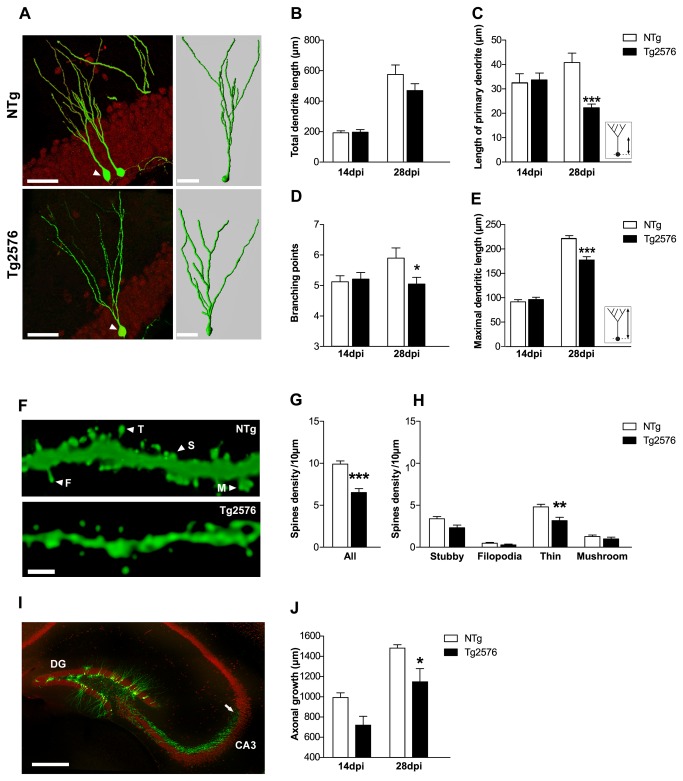
Impaired morphological development of new granule neurons in 3 month-old Tg2576 mice.(A) Confocal images (left) illustrating typical retrovirally GFP-labeled (GFP+, green) neurons 28 days post-injection (dpi) in the dentate gyrus of 3 month-old NTg and Tg2576 mice (neuronal marker NeuN, red) and their corresponding 3D reconstruction (right) illustrating the arborization and branching points of GFP+ neurons. (B) No difference was found in the total dendritic length of GFP+ neurons from NTg and Tg2576 mice (n=3-6 mice/group and 15-20 GFP+ cells/group). (C) The length of the primary dendrite was measured as indicated in inset. At 28dpi GFP+ neurons in Tg2576 mice exhibited a shorter primary dendrite compared to NTg mice (n=3-4 mice/group, n=20-25 GFP+ cells/group). (D) Number of branching points was counted in 14 and 28dpi GFP+ neurons (n=3-4 mice/group, 20-25 GFP+ cells/group). At 28dpi, GFP+ neurons exhibited less branching points in Tg2576 mice compared to NTg mice. (E) Maximal dendritic length of GFP+ neurons as quantified as illustrated in inset. At 28dpi, Tg2576 mice displayed shorter maximal dendritic length compared to NTg (n=3-4 mice/group and n=20-25 GFP+ cells/group). (F) Maximal projection of z-stacks confocal images illustrating dendritic segments from 28dpi GFP+ neurons, from which dendritic spines were counted and classified as stubby (S), filopodia (F), thin (T) or mushroom (M) according to morphological criteria described in the methods. (G) Spine density estimated from 28dpi GFP+ neurons (n=3 mice/group, 4-8 segments/mouse, 200-300µm of dendritic segments analyzed/mouse) was reduced in 3 month-old Tg2576 mice compared to NTg. (H) Among all classes, the density of thin spines was reduced in Tg2576 mice compared to NTg. (I) Confocal image depicting mature neurons (NeuN, red) and 28 day-old new neurons (GFP, green) in the dentate gyrus. Axons of GFP+ neurons (arrow) extending into the CA3 region are clearly visible, allowing the measurement of axonal length. (J) At 28dpi, axons of GFP+ neurons appeared shorter in Tg2576 compared to NTg mice. Data in B, C, D, E, G, H, J represent mean ± SEM. Data were analyzed by two-way ANOVA with Bonferroni post-hoc: *p<0.05; ***p<0.001 Tg2576 vs NTg. Scale bars: A (left)=50µm, (right)=30µm F=2µm, I=500µm.